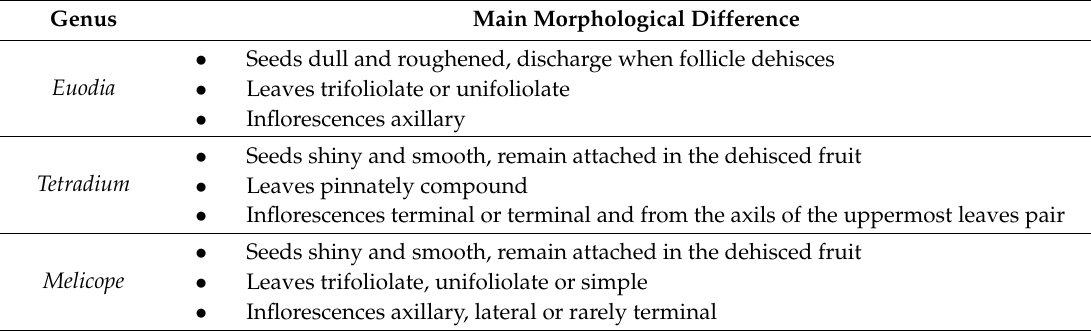
Table 1. Main morphological differences between genera Euodia , Tetradium, and Melicope. Adapted from Hartley [5].